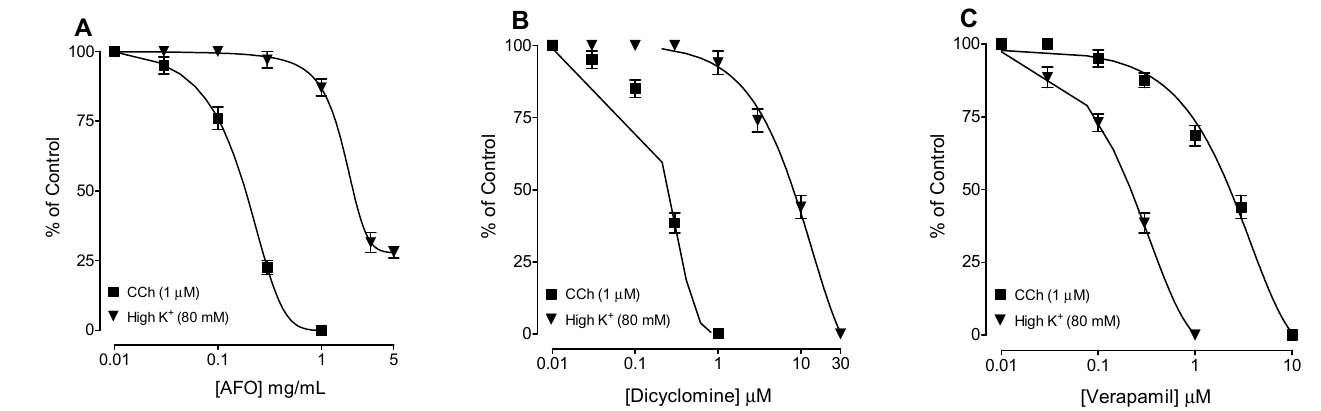
Figure 3. Concentration-dependent inhibitory effects of the ( A ) essential oil (AFO), ( B ) dicyclomine